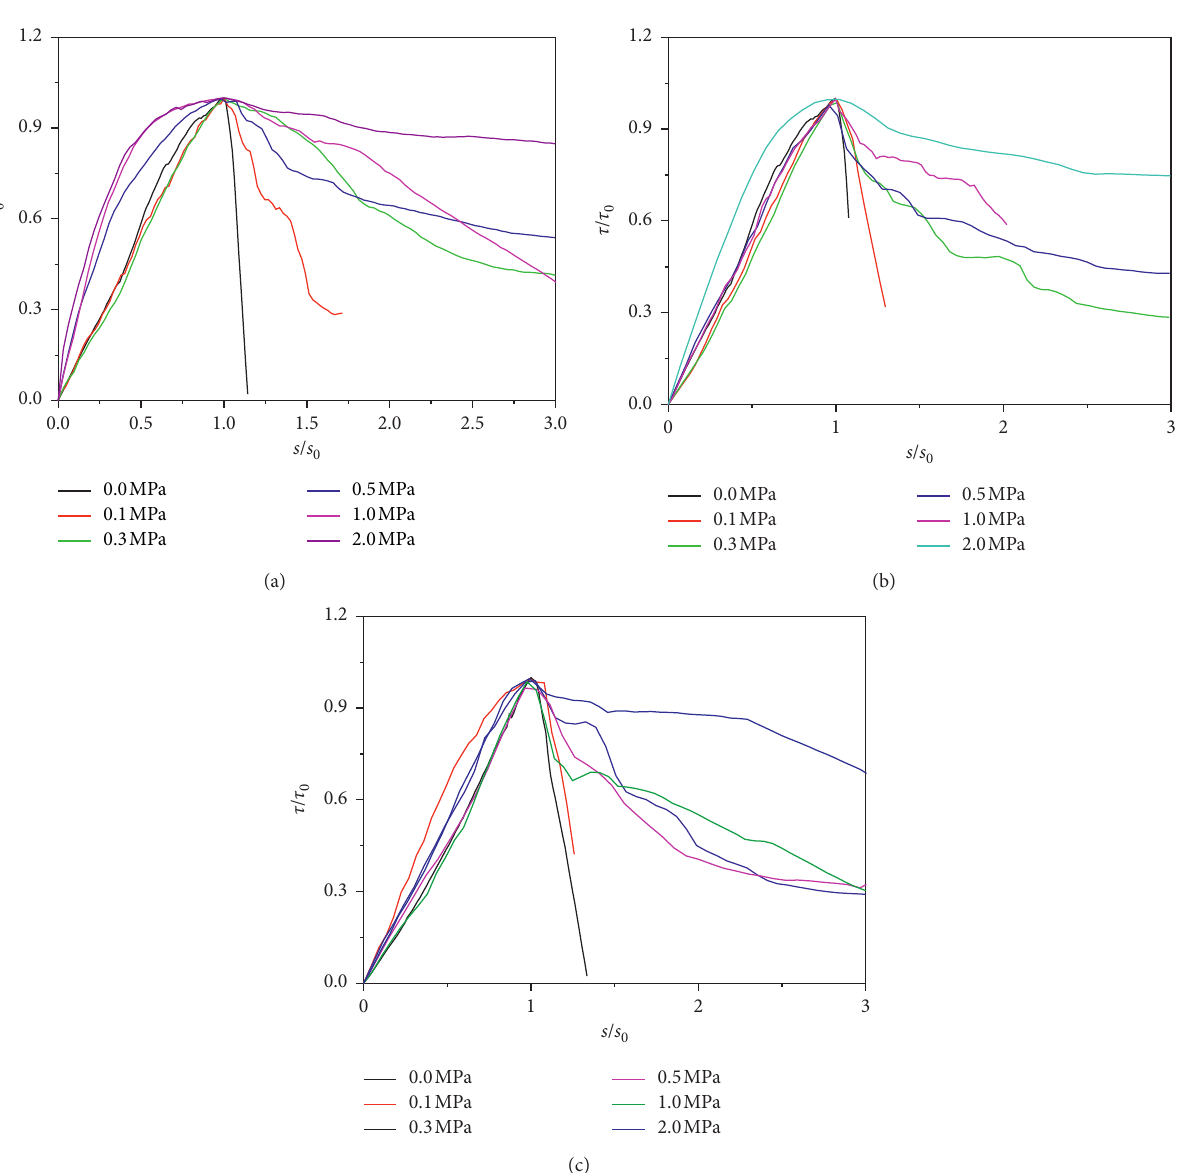
Figure 11: Normalized bond stress-slip curves for specimens with different polymer density. (a) C40P23; (b) C40P36; (c) C40P43.